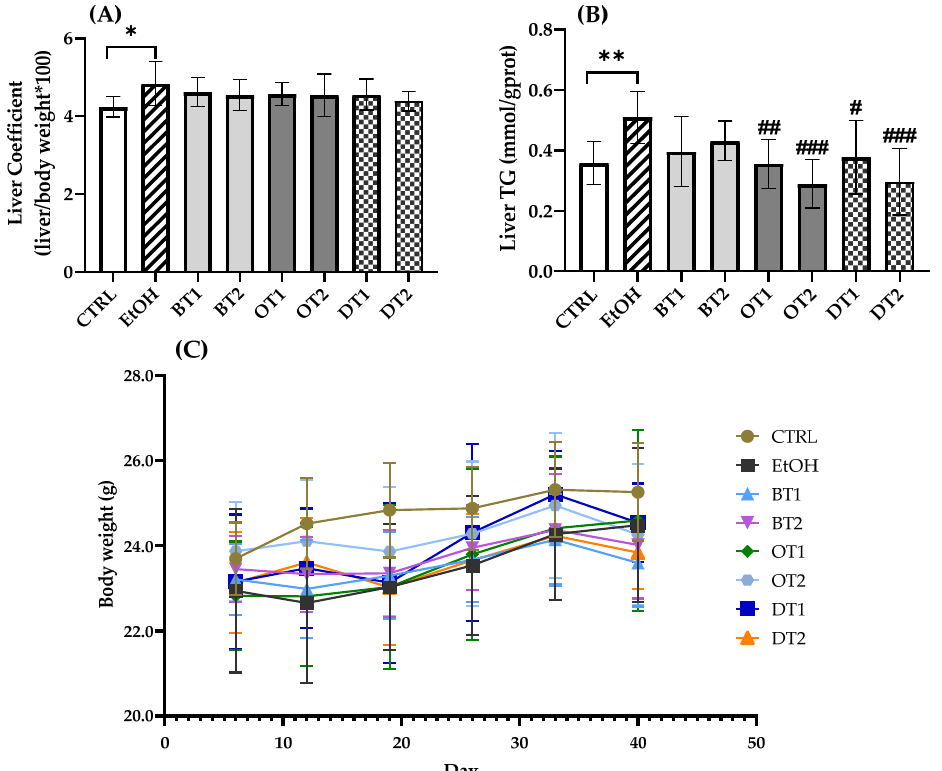
Figure 1. The effects of teas on ( A ) liver coefficient, ( B ) hepatic TG level and ( C ) body weight in mice exposed to chronic alcohol consumption. CTRL, the control group; EtOH, the model group; BT1, Dianhong Tea; BT2, Yingde Black Tea; OT1, Tieguanyin Tea; OT2, Fenghuang Danzong Tea; DT1, Fu Brick Tea; DT2, Selenium-Enriched Dark Tea. * p < 0.05, ** p < 0.01, the model group compared with the control group; # p < 0.05, ## p < 0.01, ### p < 0.001, the tea extract supplementary groups compared with the model